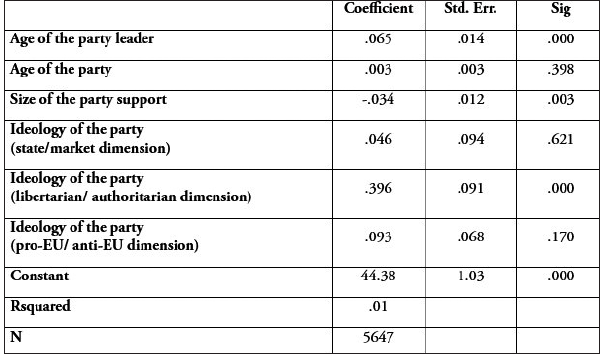
Table 5: Multiple regression model measuring the influence of party level characteristics on the age of parliamentarians 11